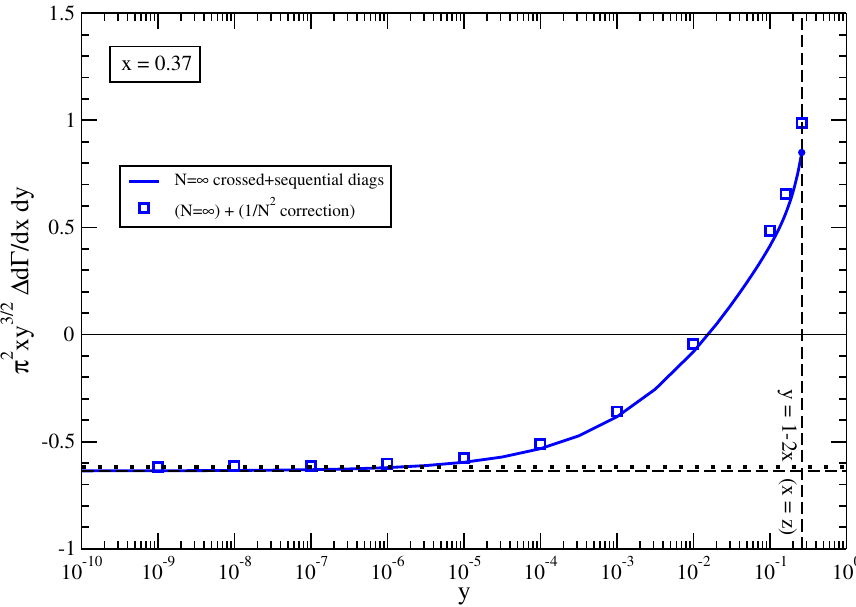
Figure 18 . A plot for x = 0 . 37 of the y dependence of the total ∆ d Γ /dx dy , multiplied by π 2 xy 3 / 2 p [and in units of Nα s ˆ q A /E , but remember that Nα s is held fixed as N → ∞ ]. The plot shows (solid curve) the N = ∞ value and (squares) the N = ∞ value plus the 1 /N 2 correction. The horizontal dashed line shows the limiting y → 0 behavior of the N = ∞ result, and the nearby horizontal dotted line shows the limiting behavior of the corrected